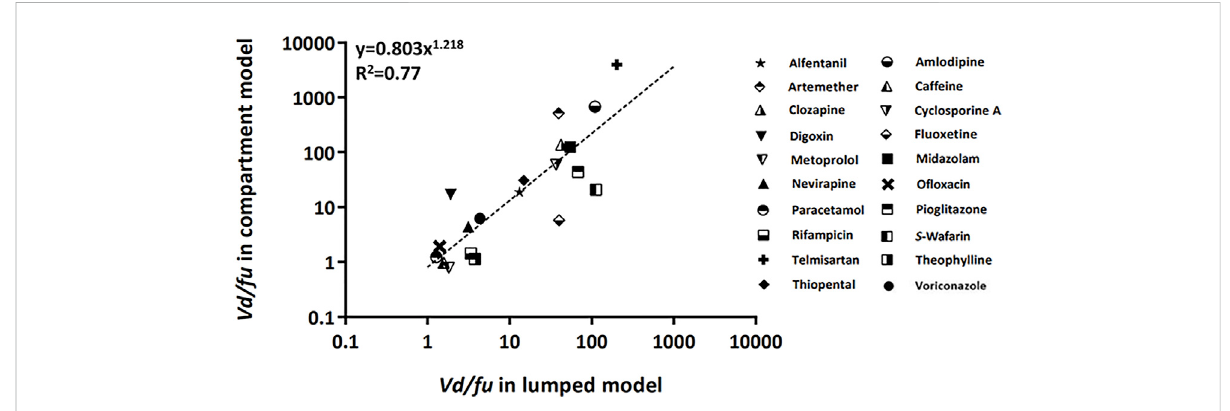
FIGURE 3 Relationship of the calculated Vd / fu between lumped and compartment models. The dashed line was fi tted to the indicated relationship ( y = ax b ). Abbreviations fu , drug-unbound fraction; Vd , volume of